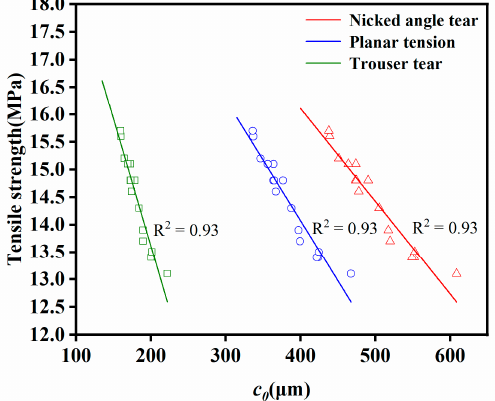
Figure 11. Linear fitting curves of tensile strength and crack precursor size under di ff erent tear modes for the EPDM rubber